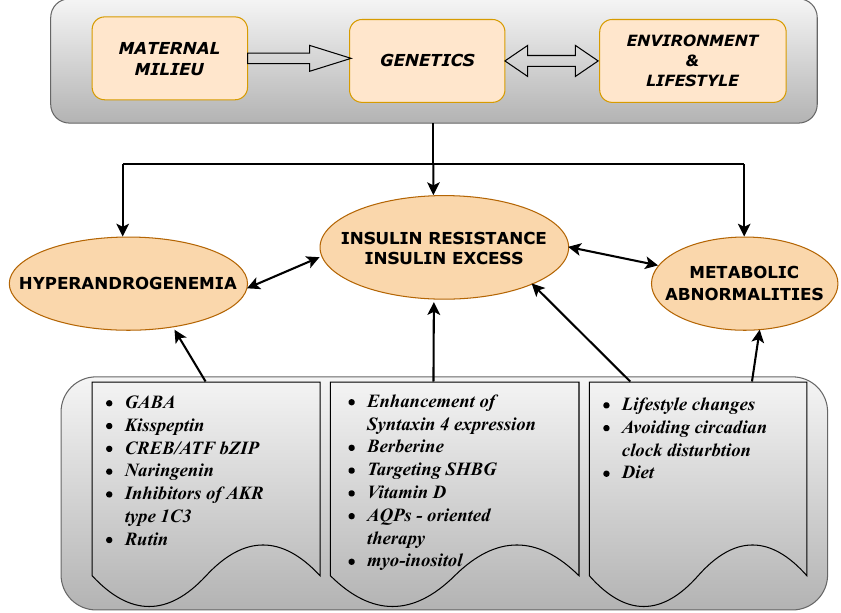
Figure 1. A conceptual diagram illustrating the basic factors contributing to the main polycystic ovary syndrome (PCOS)-related disorders and the proposed therapeutics either based on the potentially effective active substances or acting on recently proposed drug